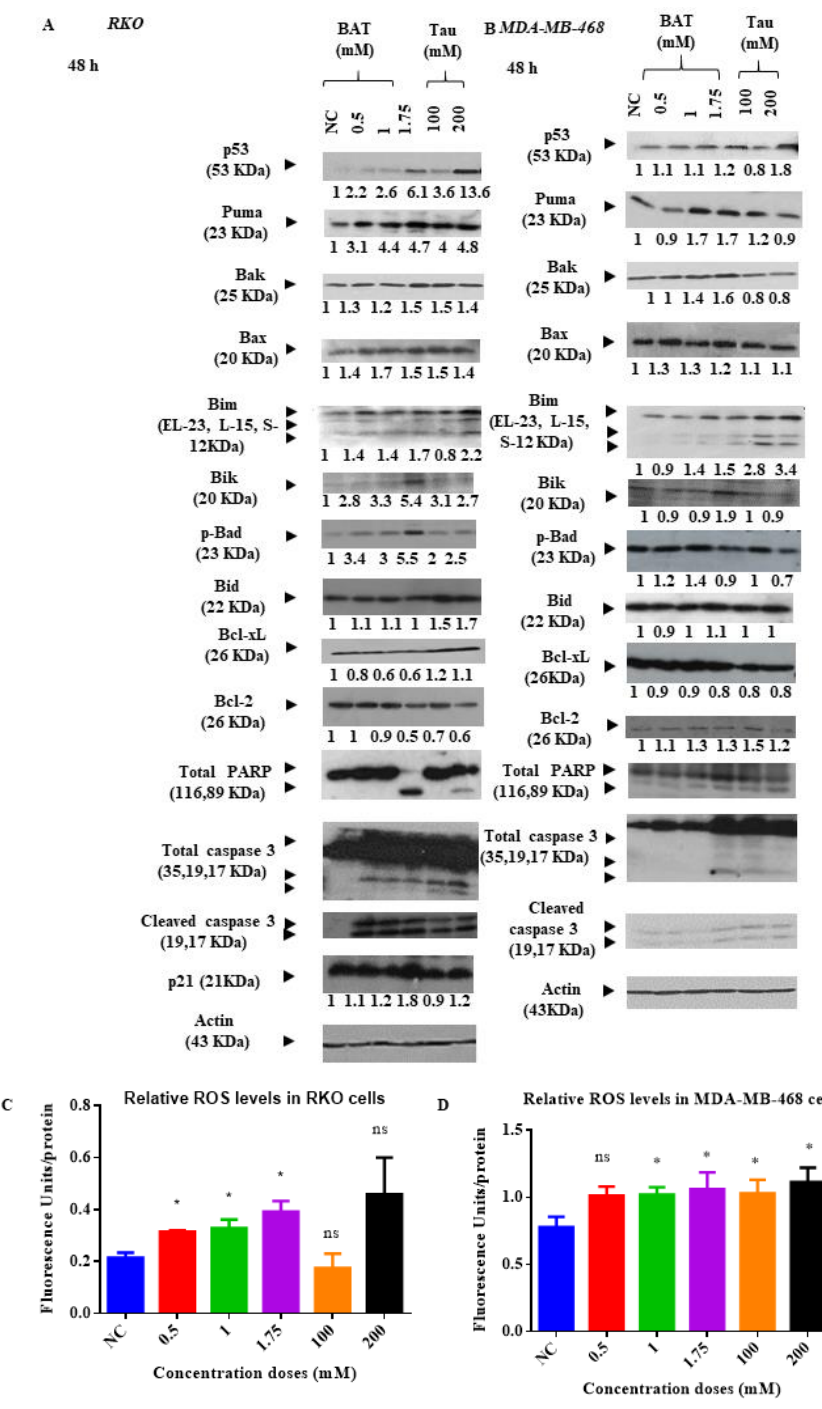
Figure 6. Both BAT and Tau induce mitochondrial apoptotic cell death in cancer cells. ( A ) RKO, ( B ) MDA-MB-468